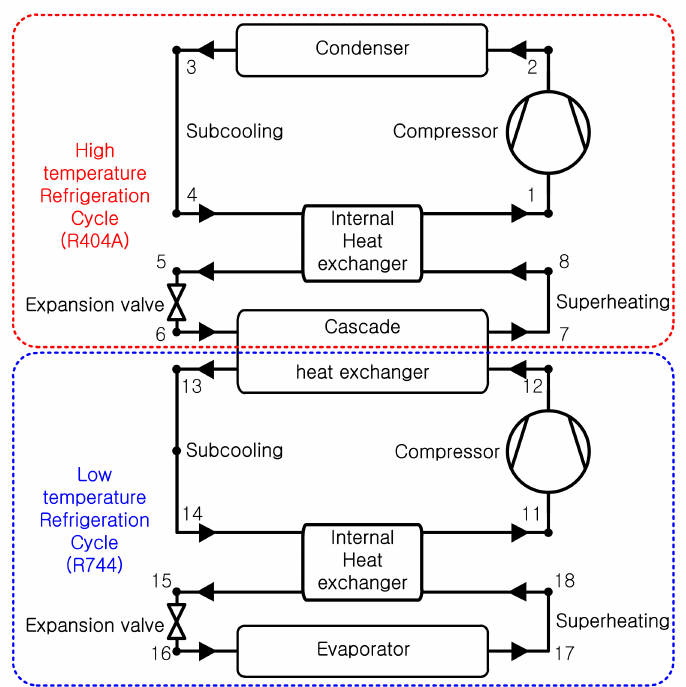
Figure 3. The conceptual diagram of the R744/R404A